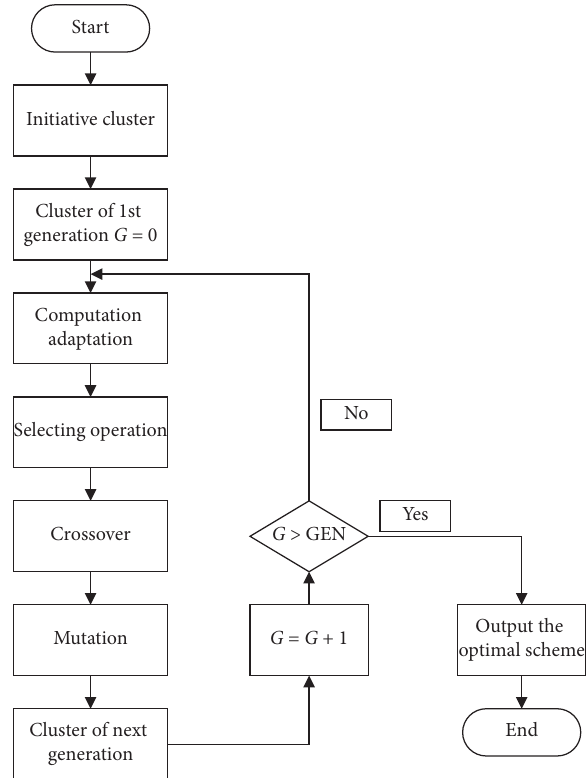
Figure 8: The structure of a genetic